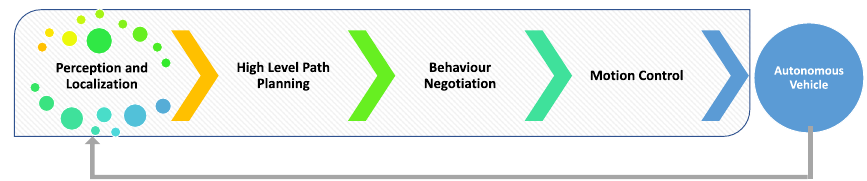
Fig. 1 Broad architecture of a perception, planning, and control workflow in autonomous vehicles